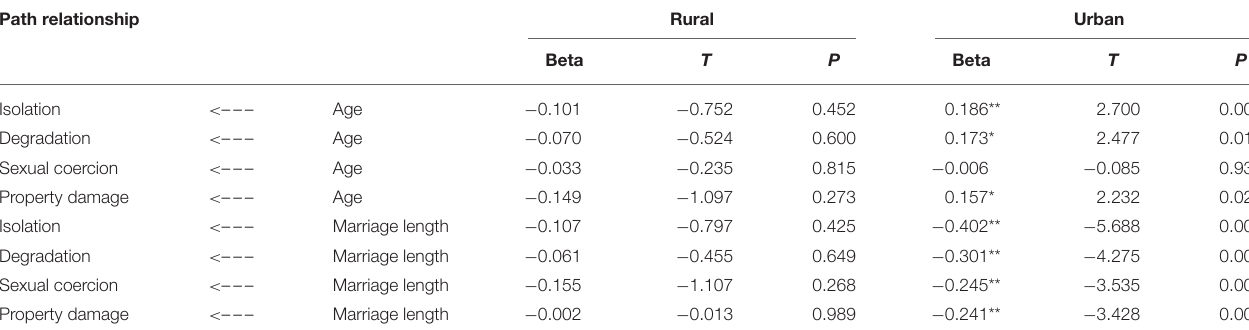
TABLE 10 | Multi-group modeling: interaction of area on associations of age and marriage length with emotional abuse victimization. Path relationship